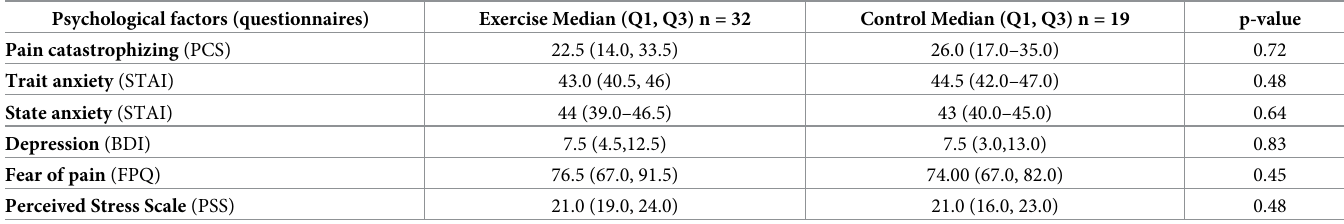
Table 1. Scores of psychological factors in the exercise and control group.